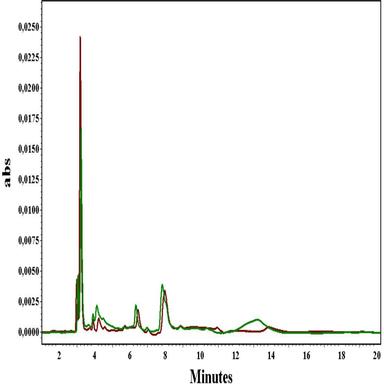
Comparison of the chromatograms obtained from analysis of volume 76 pag. 387 (green line) and volume 57 page 165 (red line).